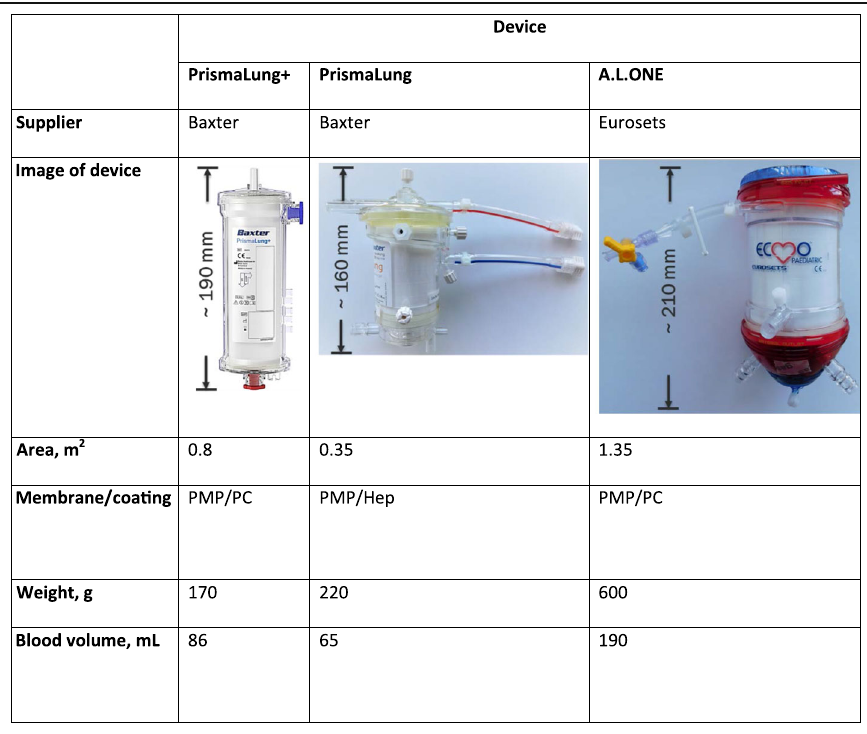
Table 1 Characteristics of the different test gas